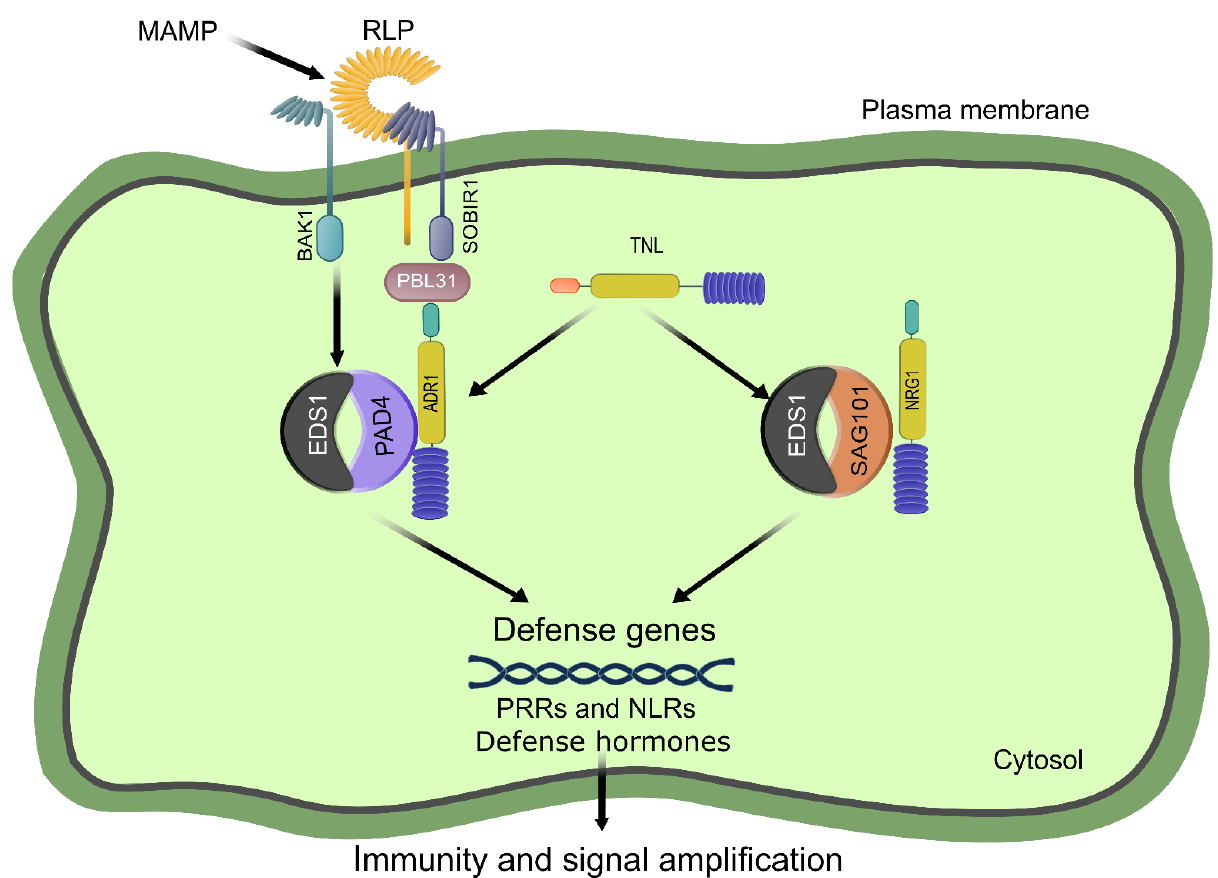
Figure 4. Convergence and integration of PRR- and NLR-mediated immunities. The current evidence connecting PTI and ETI through TNL signaling is shown. Such a point of convergence is the EDS1-PAD4-ADR1 node. See the main text for details. This figure was adapted with permission from [146]. Created with Inkscape (https://inkscape.org) and GIMP v2.10.24 (https://www.gimp.org).